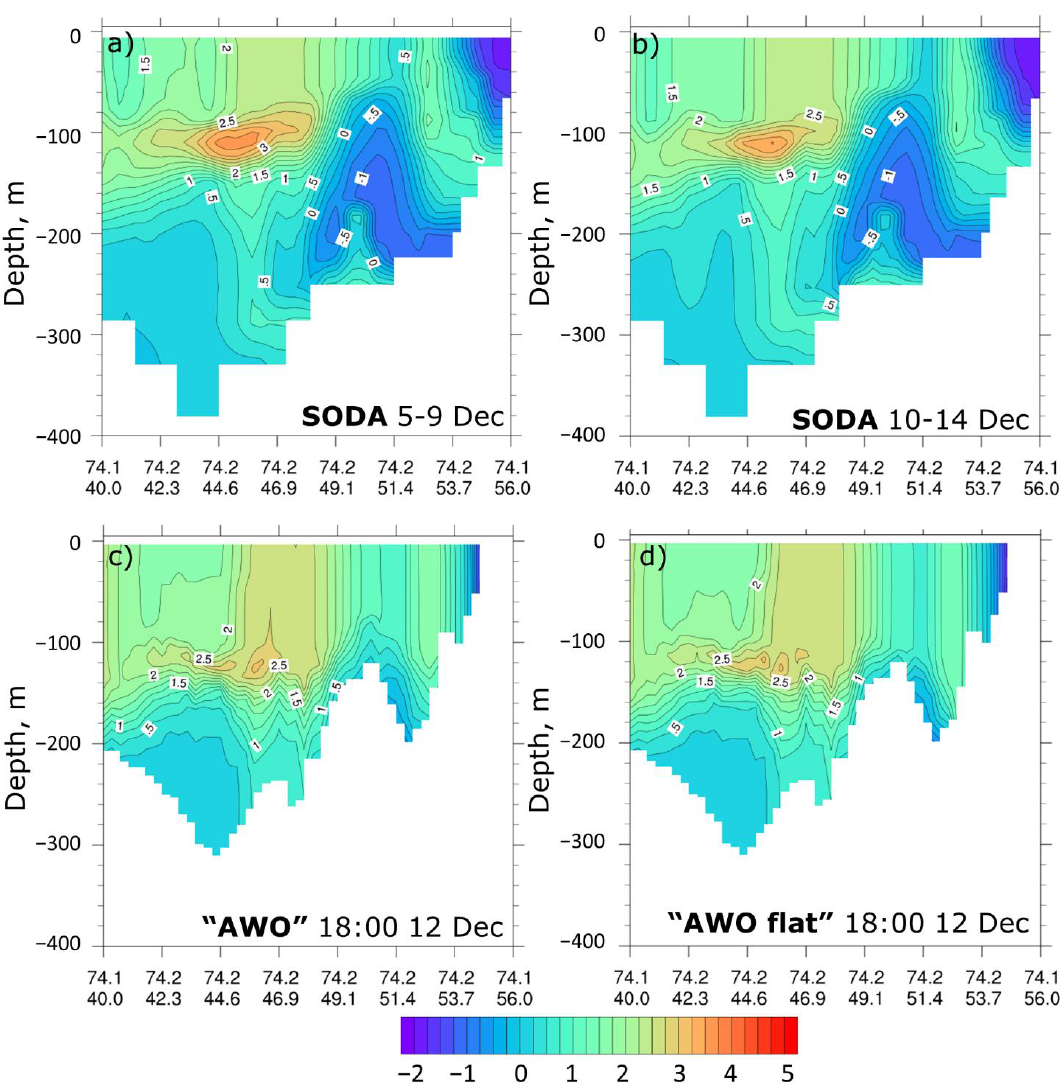
Figure 11. Cross-section of water temperature (°C) across 74.1° N in SODA reanalysis for December 7 (average over 5 – 9 December) ( a ), for December 12 (average over 10 – 14 December) ( b ) and in “AWO” ( c ) a nd “AWO flat” ( d ) experiments at the bora end (18 UTC 12 December).